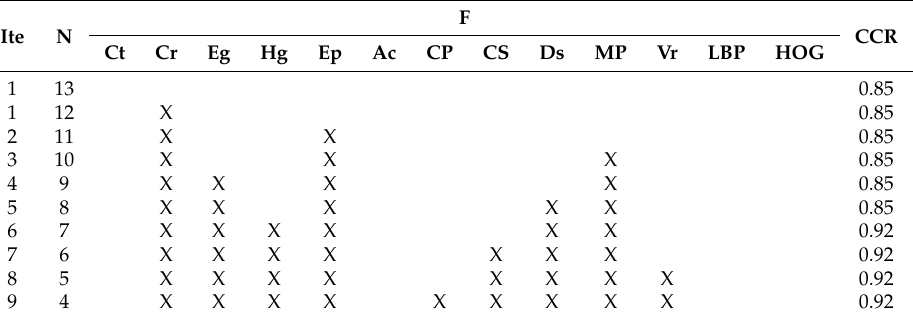
Table 7. Intra-modal selection of texture features. Correct classification rates obtained when applying the proposed selection process on DECEDM texture features. Ite: iteration. N: number of features kept. F: features. CCR: correct recognition rate.